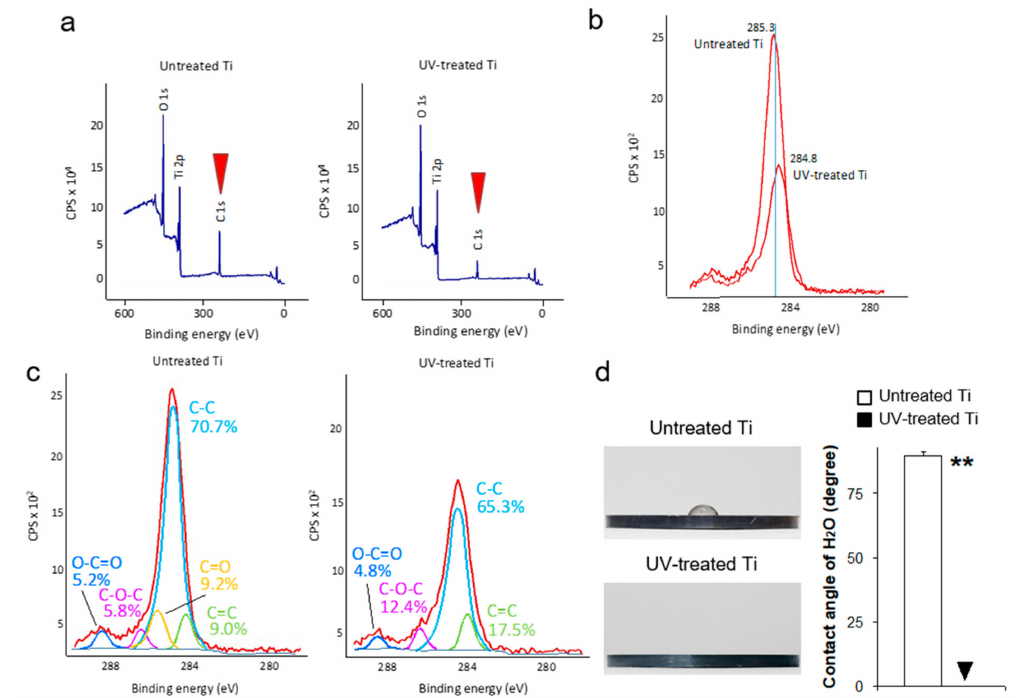
Figure 1. Ultraviolet (UV)-light-induced physicochemical changes on the machined titanium surfaces. ( a ) X-ray photoelec- tron spectroscopy (XPS) spectrum for the untreated control and UV-treated titanium surfaces. The red arrowhead represents the C1s peak. ( b ) Spectrum showing the C1s peak for the untreated control titanium and UV-treated titanium. ( c ) Spectrum representing the peak fitting analysis for C1s. ( d ) A total of 10 µ L of H 2 O was placed on the untreated and UV-treated titanium, to evaluate surface hydrophilicity. The line graph shows the average contact angle of H 2 O placed on each surface (** P <